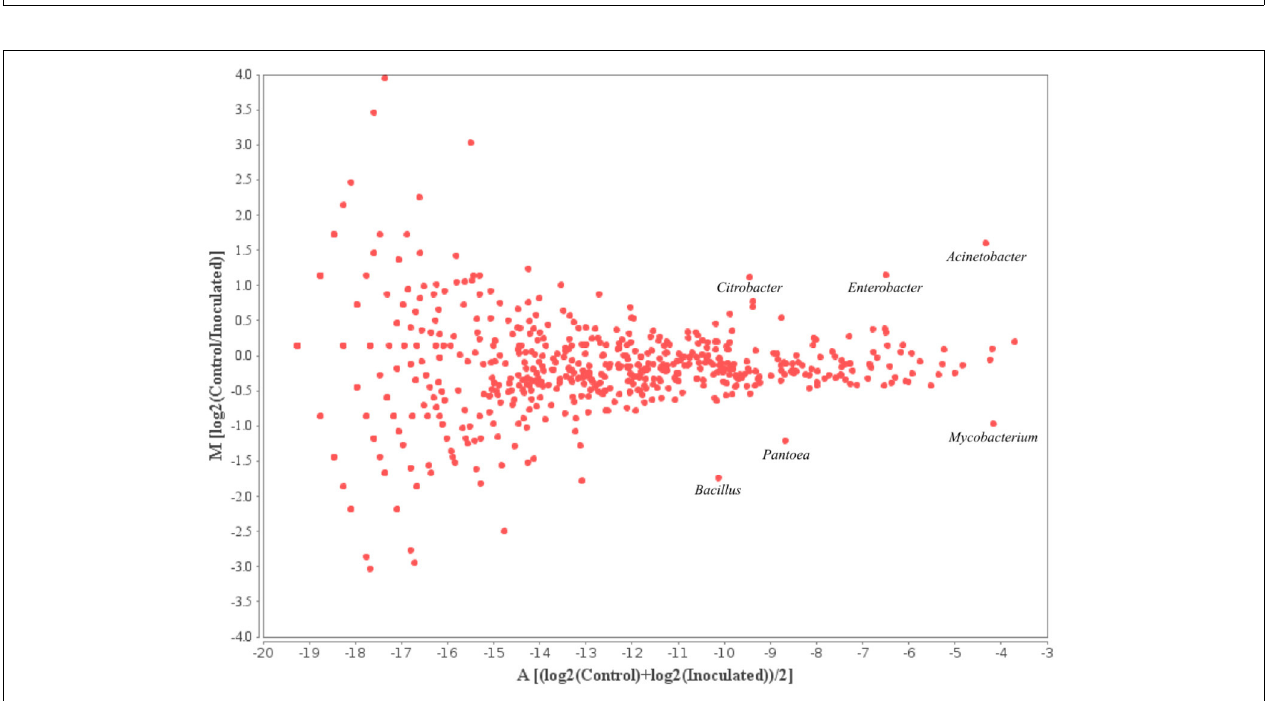
FIGURE 7 | MA-Plot visualizing the values of annotated genera within the t0 samples. Log2(Control/Inoculated) indicates the fold-changes in the abundances of annotated genera between the two samples; (log2(Control) + log2(Inoculated))/2 shows the average abundance of an annotated genus.